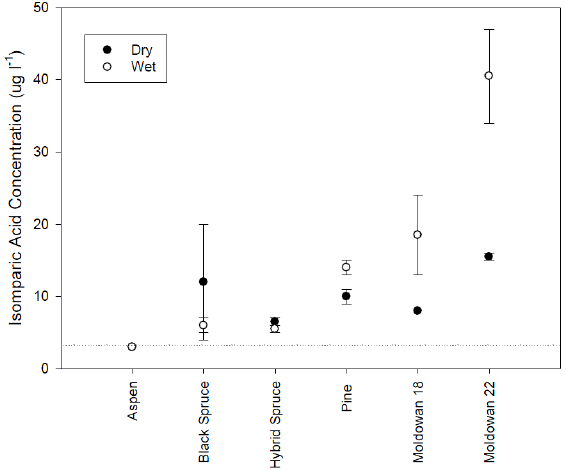
Figure 7. Mean isopimaric acid concentrations and standard error ( n = 2) for different tree species and wood chip moisture conditions. Dashed line represents limit of detection. Forests 2016 , 7 , x 12 of 14